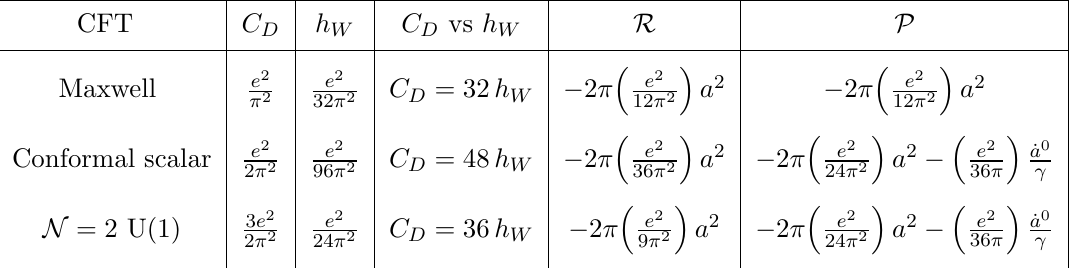
(cid:0) (cid:1) R i e d(cid:28) (cid:30) . The third